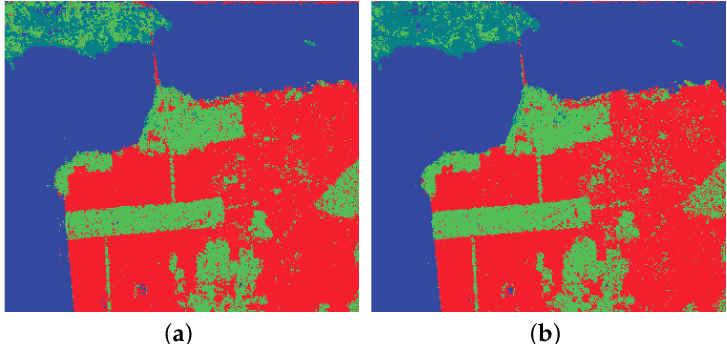
Figure 14. The visual classification results by CNN and QCNN on San Francisco data set. ( a ) The classification results by CNN. ( b ) The classification result by QCNN.